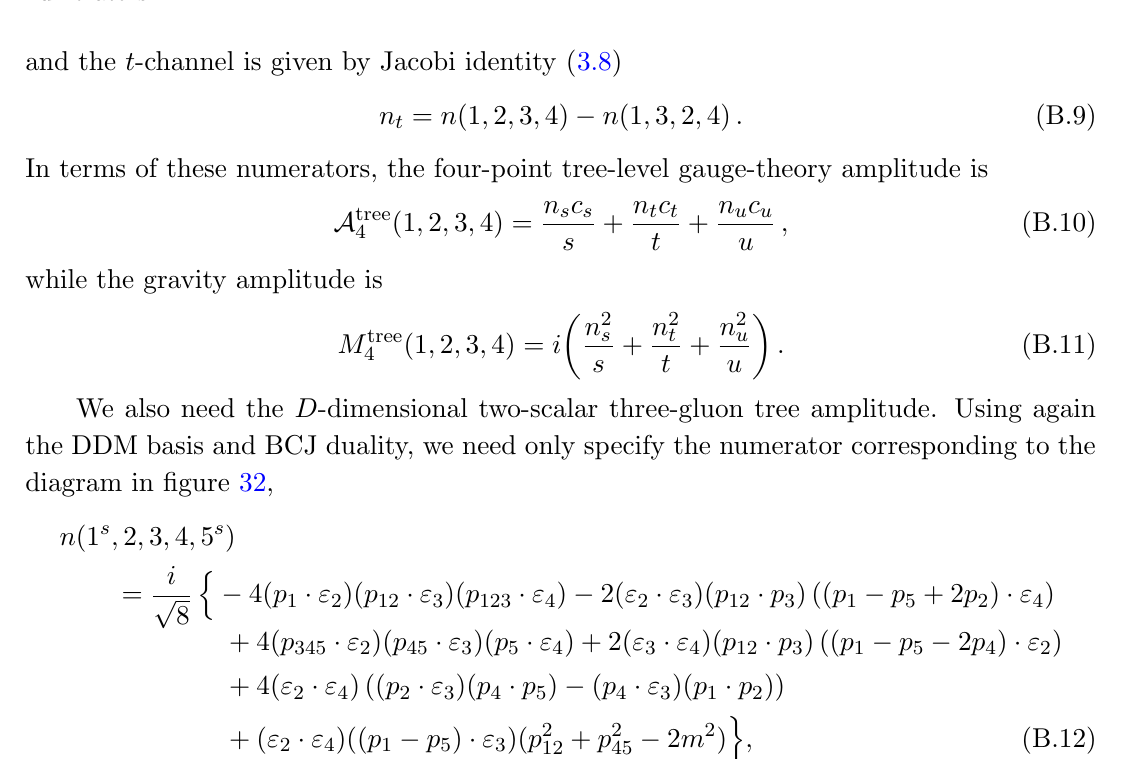
Figure 32 . The (cid:12)ve-point diagram whose kinematic numerator determines all other diagram